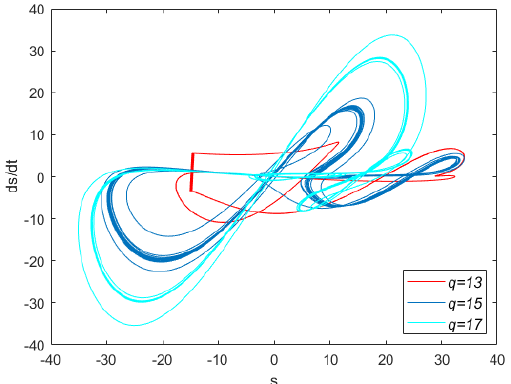
x parameter versus time for various amounts of Figure 8. Variation of the Figure 8. Variation of the x 1 parameter versus time for various amounts of q , p = 19, and β = 200. 1 200 β = .